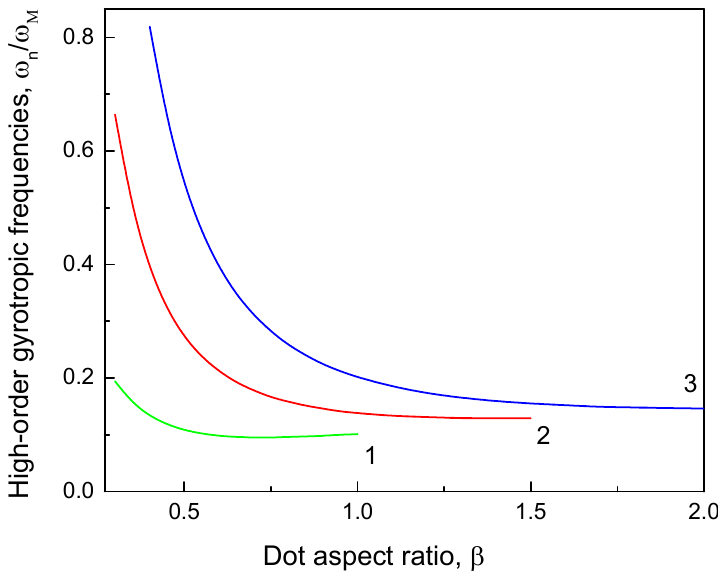
Figure 3. The high-order vortex eigenfrequencies ω 1 ( β ) ( 1 ) , ω 2 ( β ) ( 2 ) , and ω 3 ( β ) ( 3 ) of the delocalized gyrotropic modes with the numbers n = 1, 2, and 3 calculated by Equation (14). The reduced dot radius r = R / L e = 10.